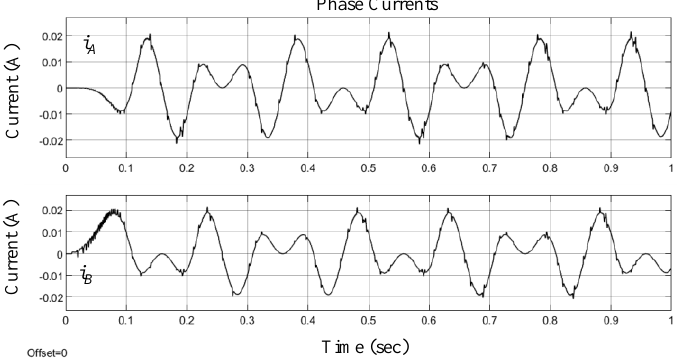
Figure 14. The simulated stator current responses for the speed command of 0.314 rad/s.